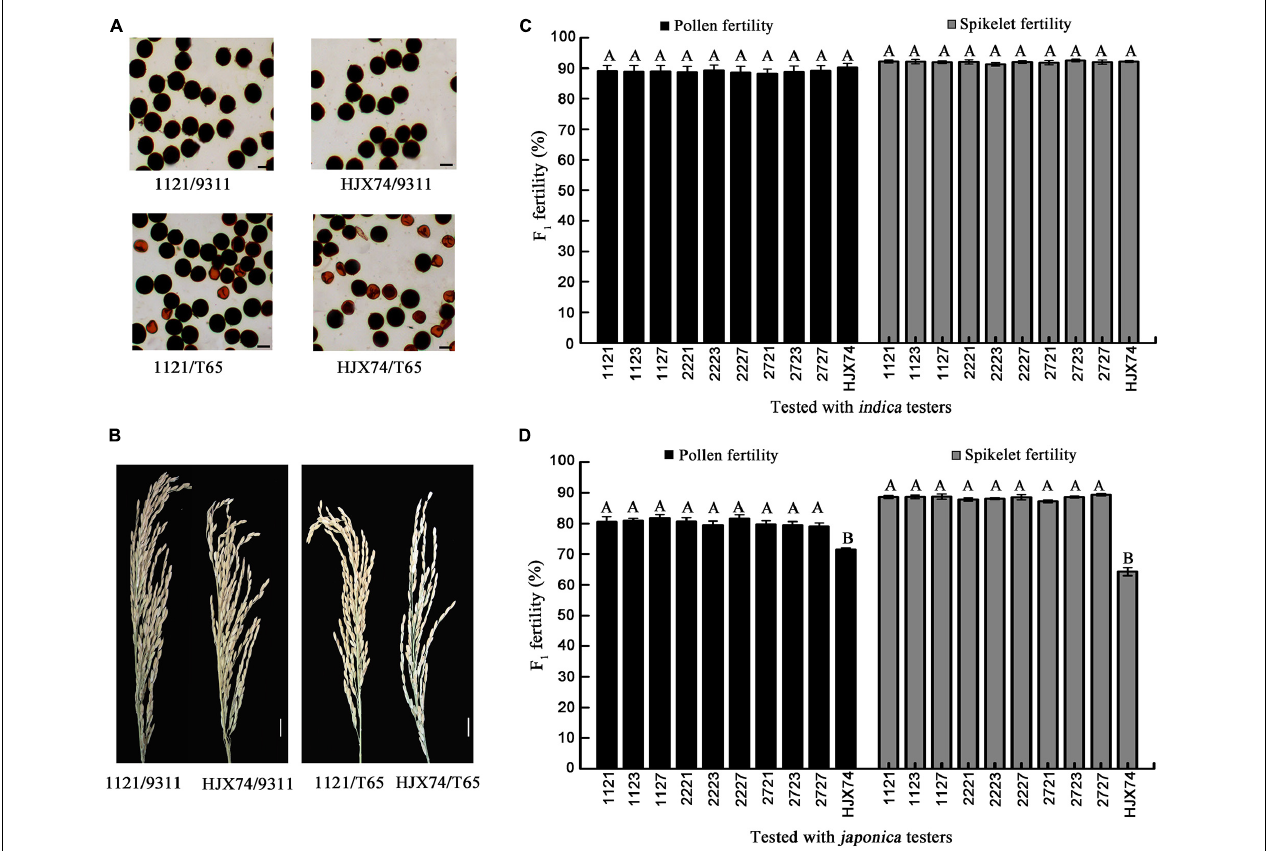
FIGURE 5 | Compatibility of WCILs. (A) Pollen grains stained by I 2 -KI solution in F 1 hybrids of four crosses. Scale bar, 30 µ m. (B) Spikelet fertility of the panicles in F 1 hybrids. Scale bar, 2 cm. (C) Pollen fertility and spikelet fertility of the F 1 hybrids from the crosses between WCILs (HJX74 as control) and indica testers (See Supplementary Tables 8–9 ). (D) Pollen fertility and spikelet fertility of the F 1 hybrids from the crosses between WCILs (HJX74 as control) and japonica testers